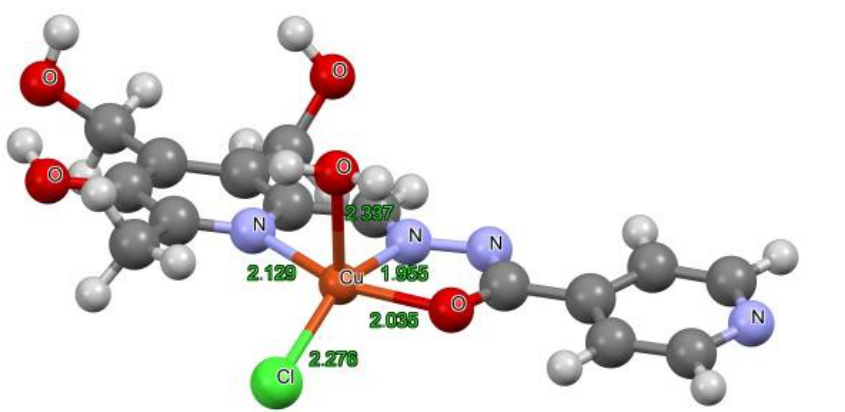
Figure 6. Structure of the [Cu L (H 2 O)Cl] complex optimized on the B3LYP/def2-TZVPP level, ac- counting for solvent effects in the C-PCM model and dispersion correction (D3BJ).